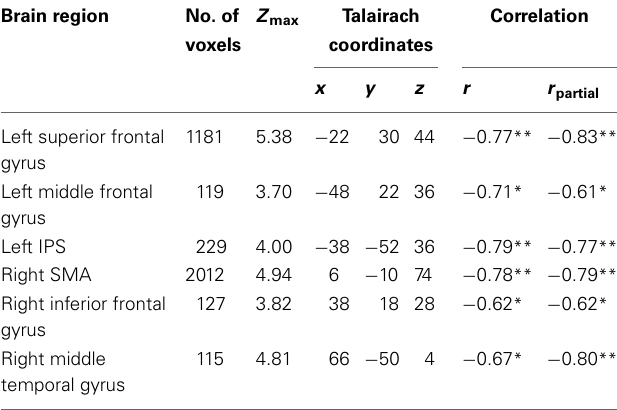
Table 1 | Brain areas that showed significant negative correlations with